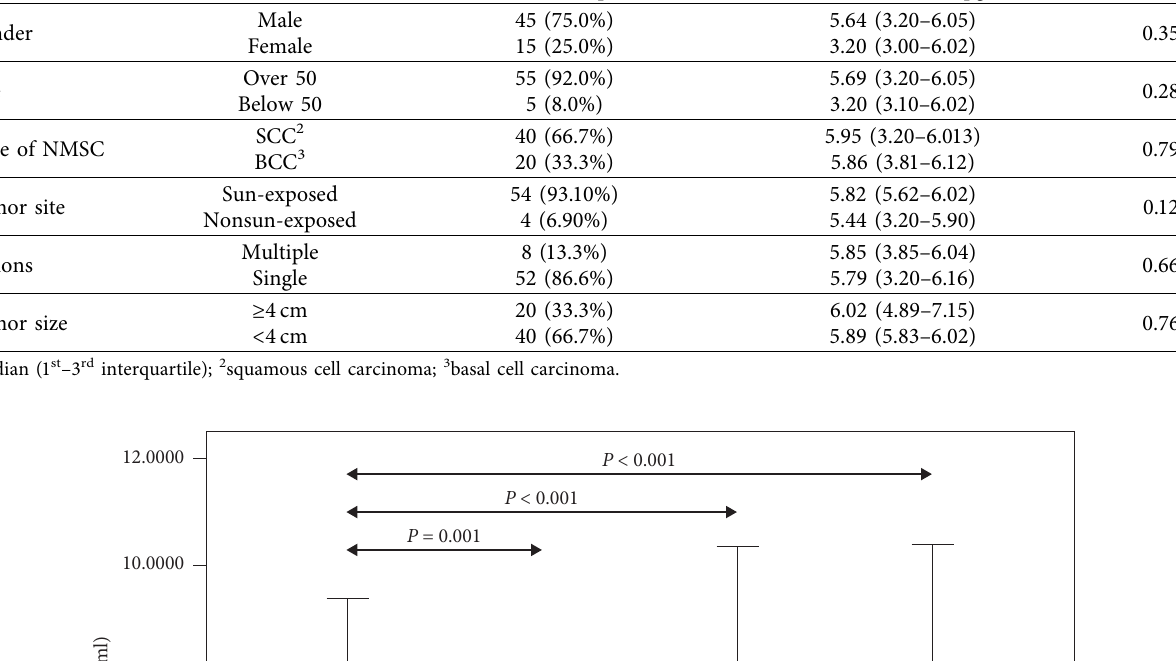
Table 1: Clinicopathologic characteristics of NMSC patients and their respective IL-17A serum levels in each subgroup. Variables